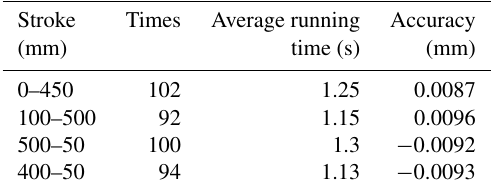
Table 1. Positioning accuracy under different strokes. Stroke